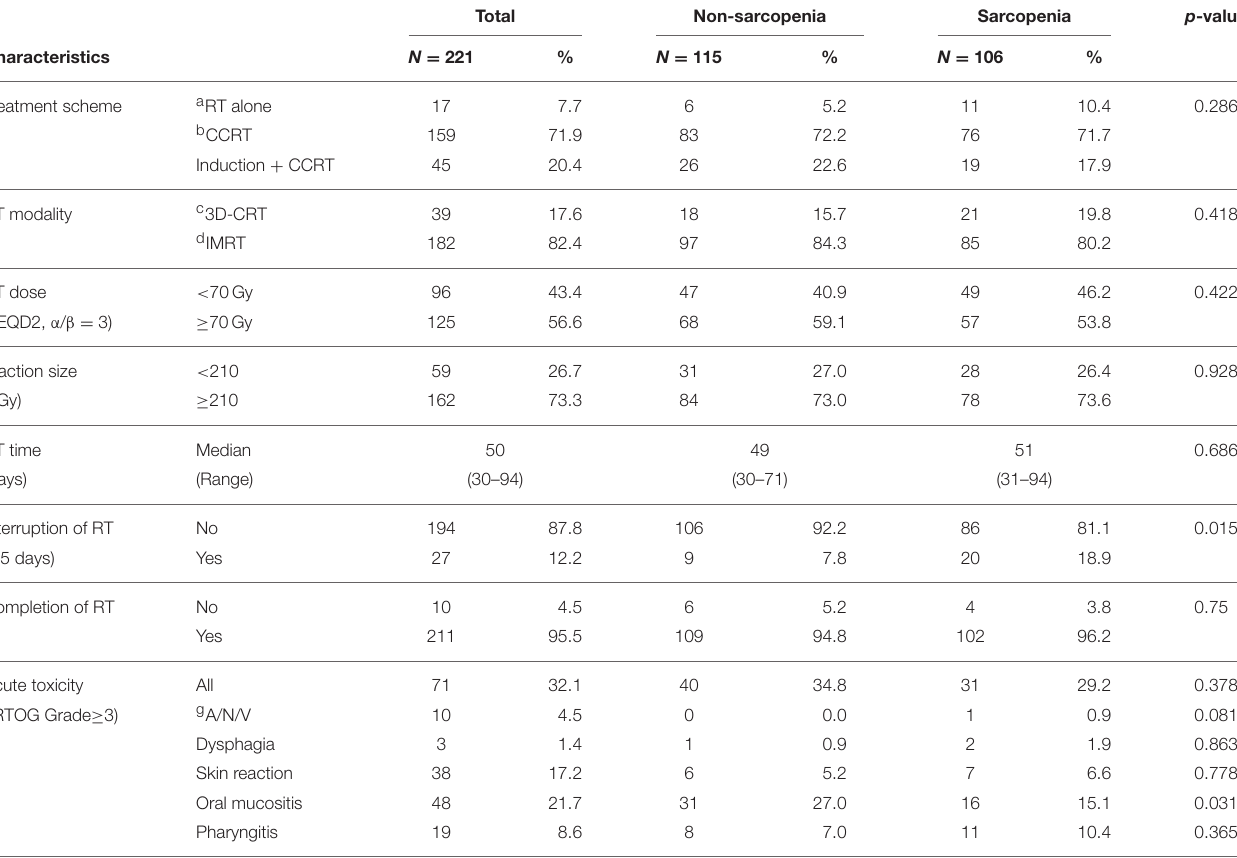
Total Non-sarcopenia Sarcopenia p -value